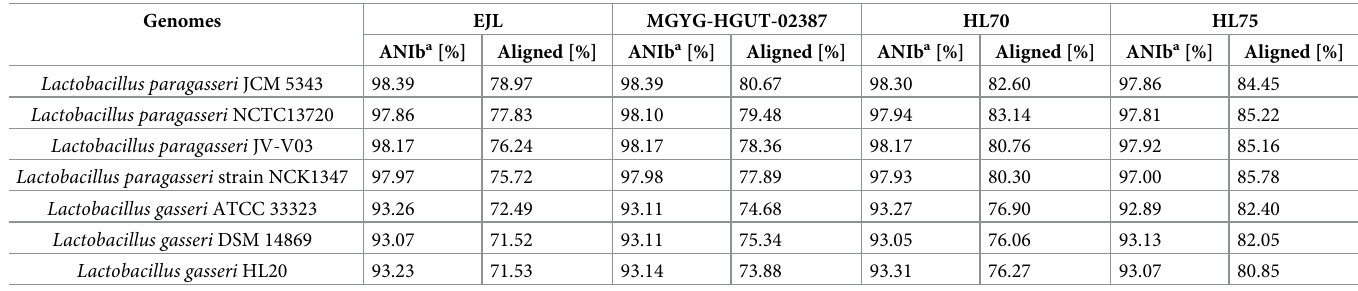
Table 1. ANI values of Lactobacillus gasseri EJL, L . gasseri MGYG-HGUT-02387, L . gasseri HL70 and L . gasseri HL75 with other L . gasseri and L . paragasseri strains.